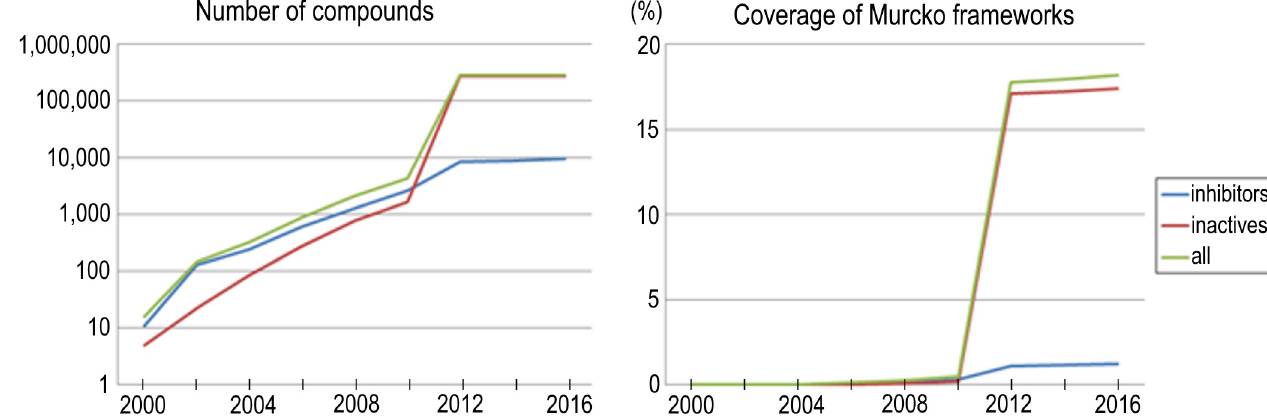
Fig 6. Transition in the number of unique compounds and coverage of Murcko frameworks for hERG inhibitors, inactive compounds, and all reported compounds. Coverage of Murcko frameworks was calculated as the ratio to those of all ChEMBL22 compounds (438,551).